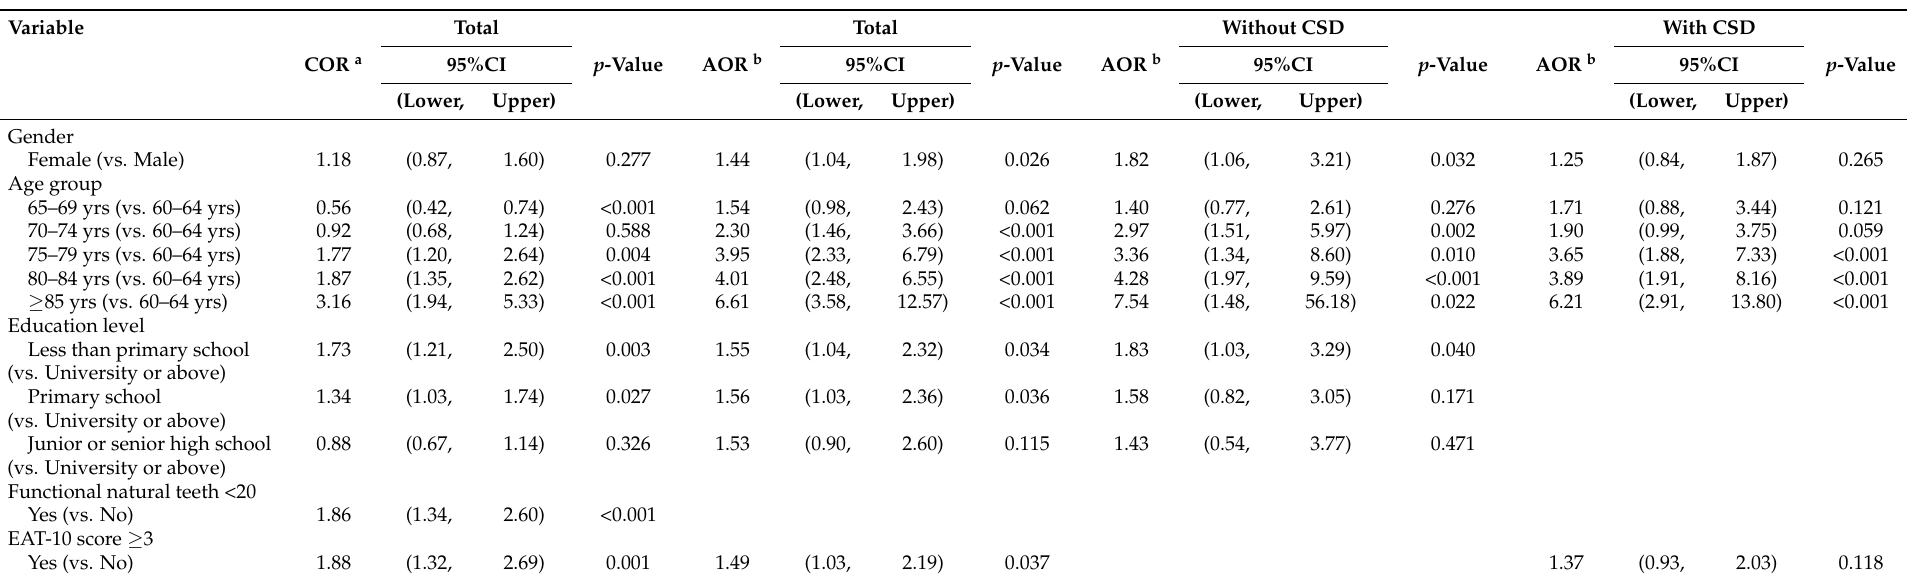
Table 5. Factor of decreased tongue pressure of